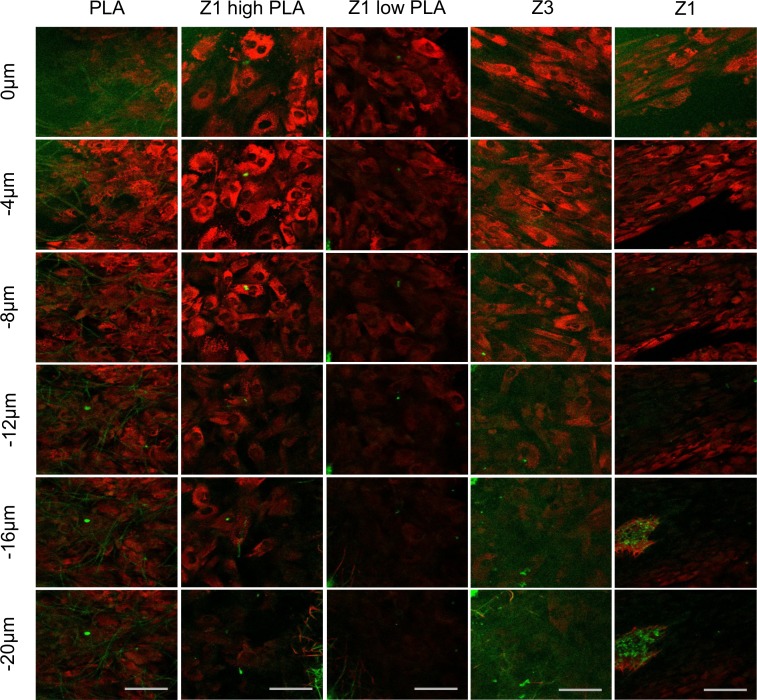
Fluorescence microscopy and scaffold fibre second harmonic generation using confocal microscopy.Cells (red) and fibre SHG signal (green) for each of the 5 constructs imaged from the scaffold surface (0μm) to 20μm depth. All scale bars equivalent to 50μm.